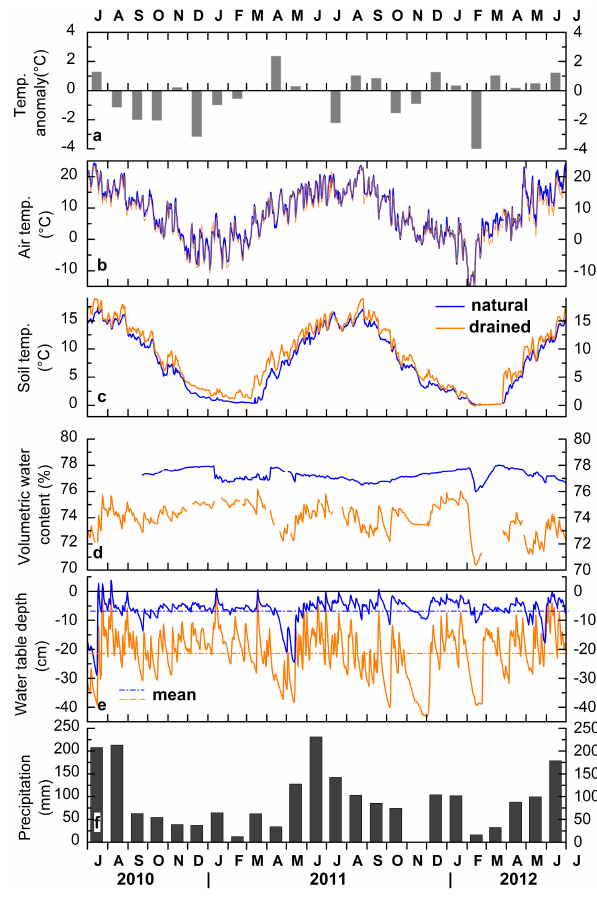
Figure 3. Time series of daily means (b, c, d, e) and monthly val- ues (a, f) of environmental parameters from 1 July 2010 to 30 June 2012. The temperature anomaly is based on 40 years of long-term data, provided by the German weather service (DWD). The air tem- peratures were measured at 6 and 30m height in Schechenfilz (nat- ural) and in Mooseurach (drained), respectively. The presented soil temperatures were measured at 0.1m depth. The volumetric water content is the average of the 30cm upper peat layer. Over the 2 mea- surement years, the mean water table depth is − 0.21 ± 0.08m at the drained site and − 0.06 ± 0.04m at the natural site.